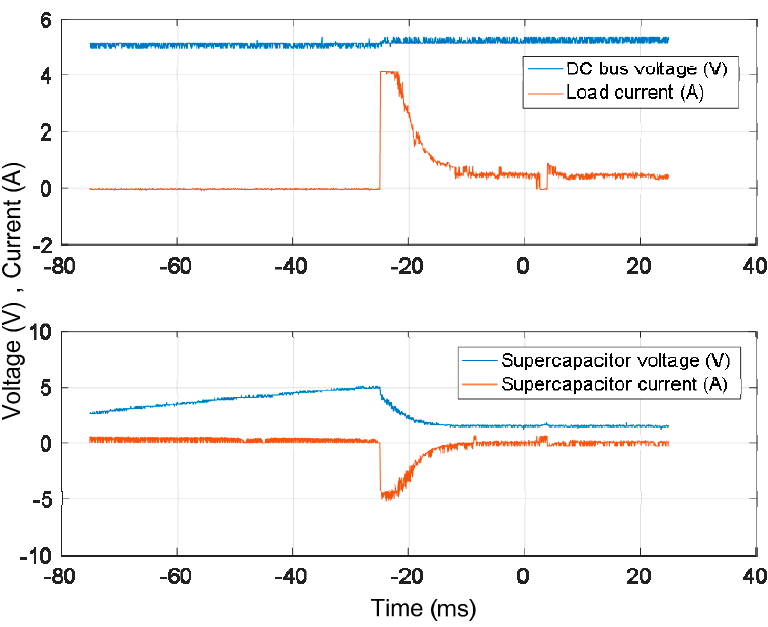
Figure 23. The voltages of the DC bus and the supercapacitor and the currents from the capacitor and the load.